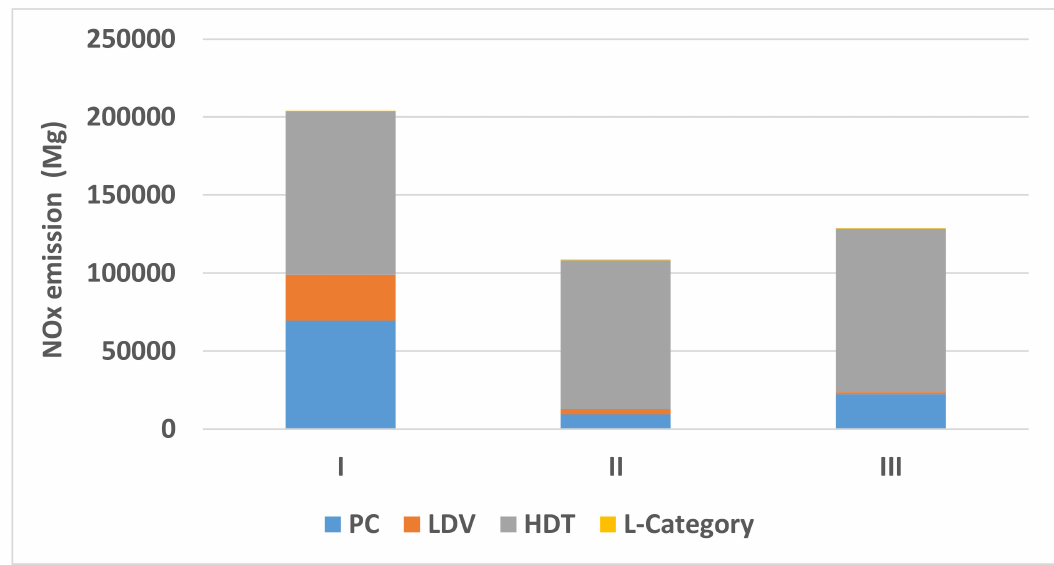
Figure 5. Comparison of NO x emissions for three